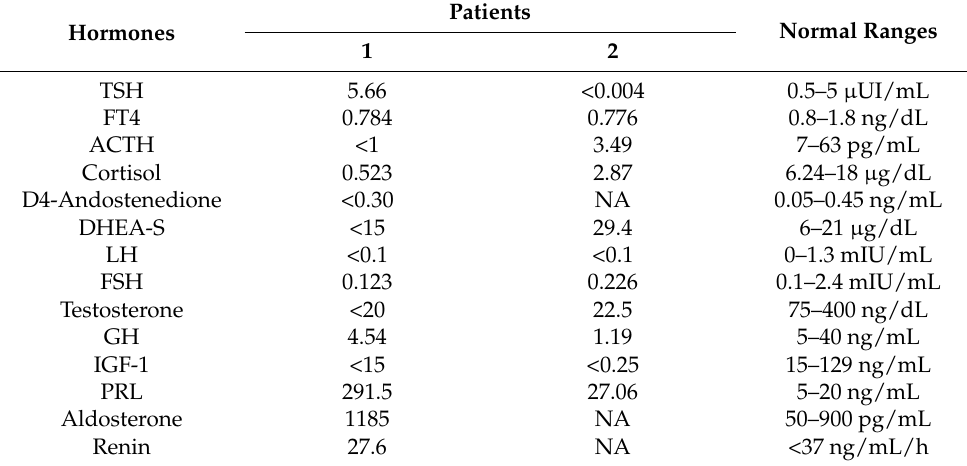
Table 1. Laboratory hormone tests of the two newborns diagnosed with CPHD. Hormones